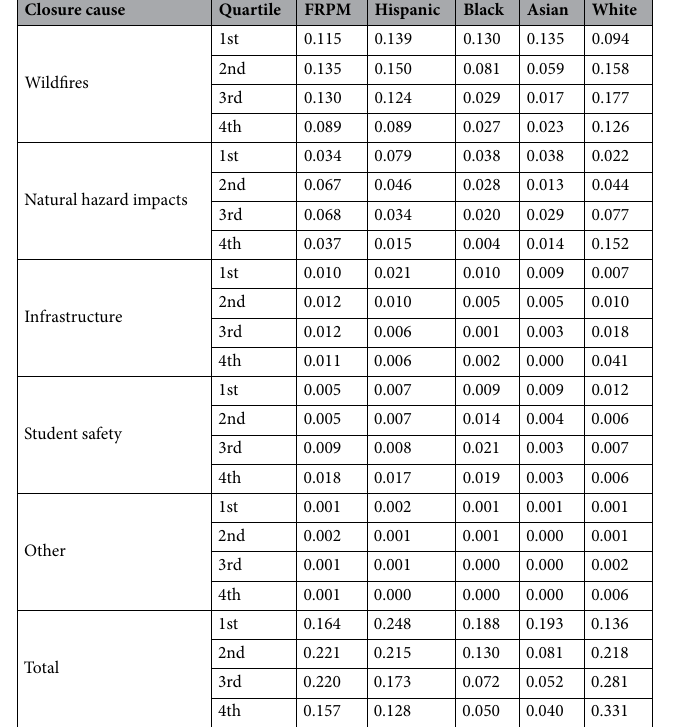
Table 2. Average number of closure days by closure cause by subpopulation quartile. Average closure days are rounded to the nearest